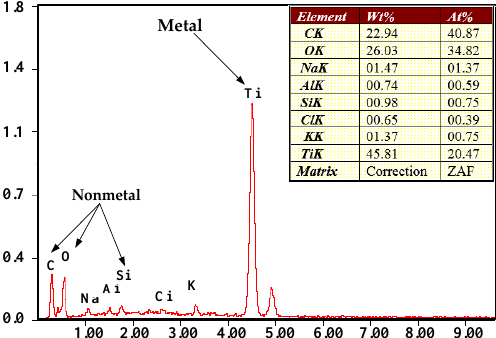
Figure 7. EDX spectrum of tool electrode end face after short-circuiting.